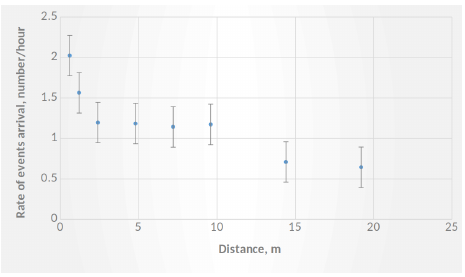
Figure 4. Rate of events vs detector